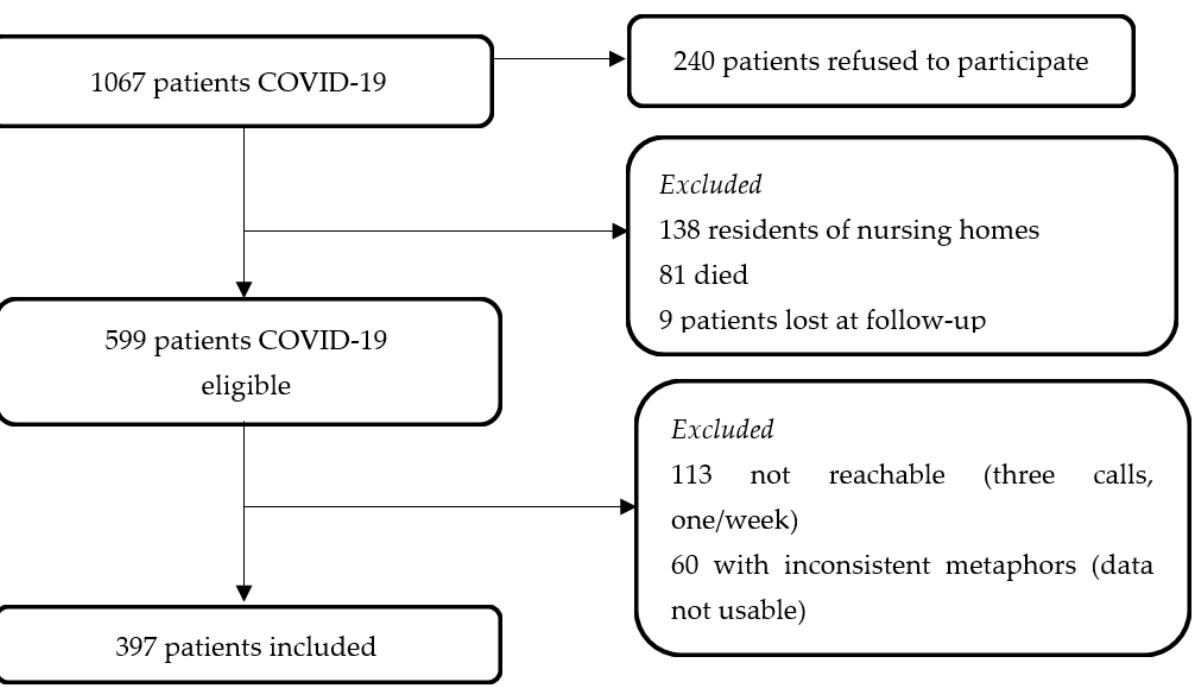
Figure 1. Flow chart showing patients diagnosed with COVID-19 interviewed six months after the onset. Legend. COVID-19, Coronavirus Disease 19.